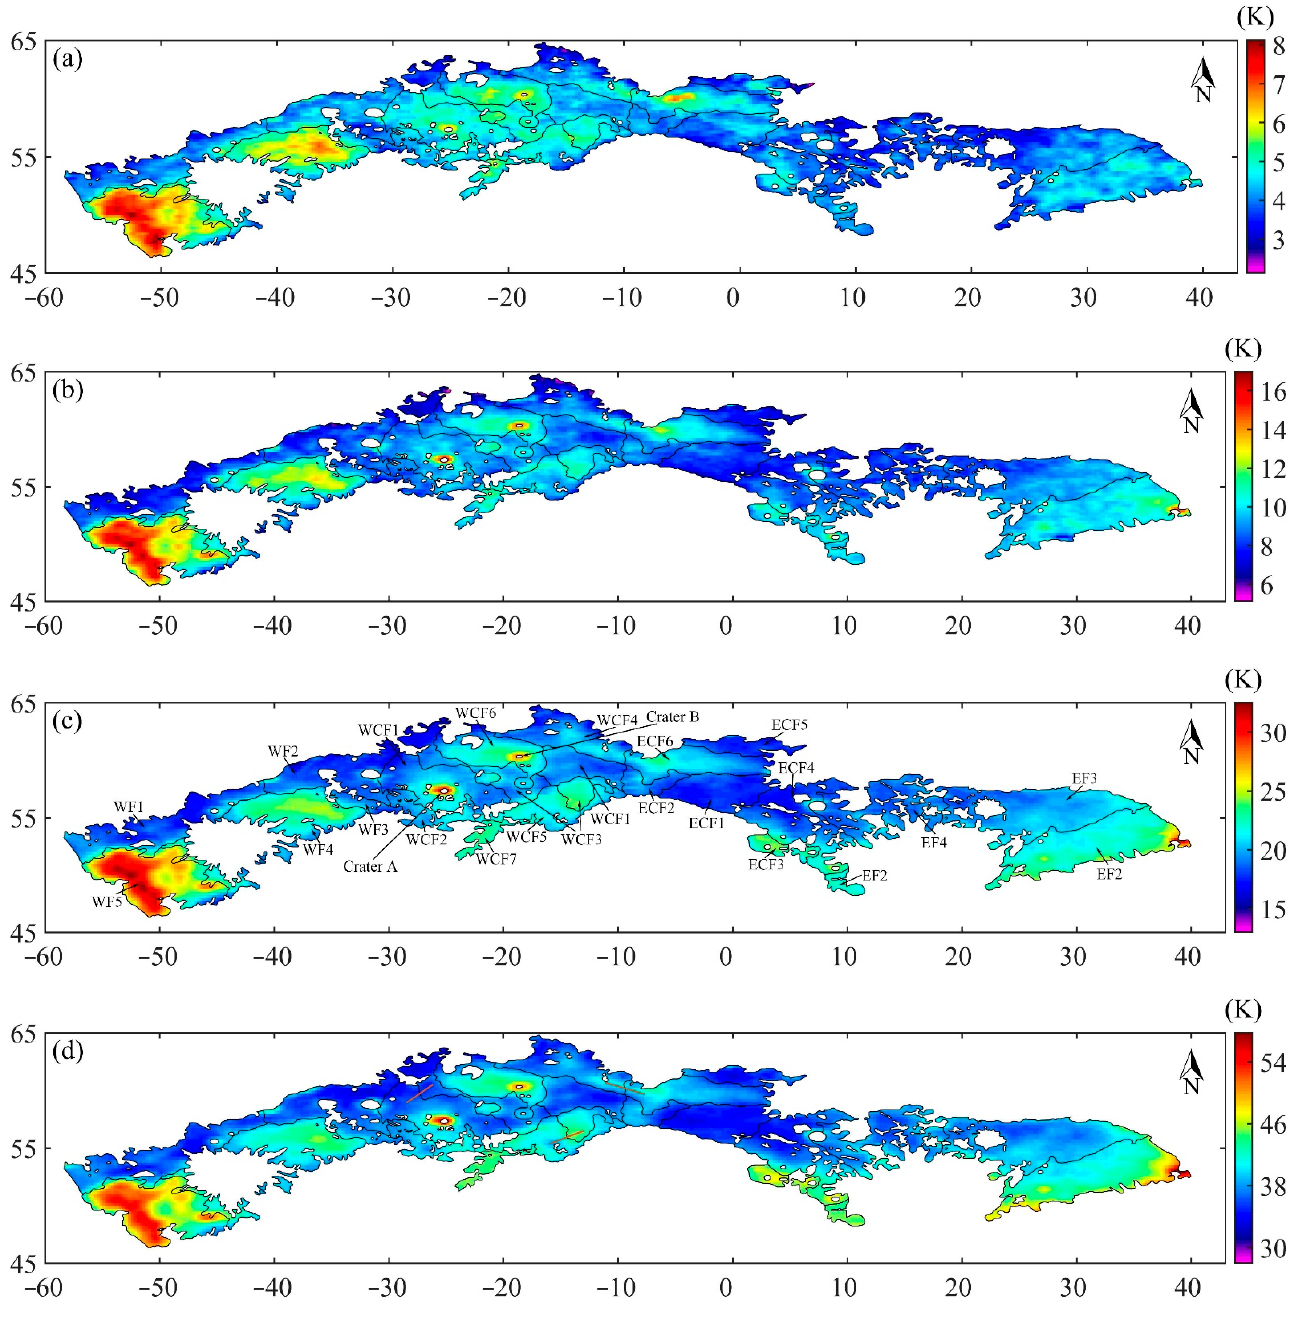
Figure 6. TB difference maps of Mare Frigoris: ( a ) 3.0 GHz, ( b ) 7.8 GHz, ( c ) 19.35 GHz, and ( d ) 37 GHz (equidistant cylindrical projection). The black lines are the geologic boundaries of Mare Frigoris mapped by Kramer et al. [2]. The orange lines are the profiles from the western WCF1 unit to the western WCF3 unit, from the WCF4 unit to the ECF6 unit, and from the WCF5 unit to the eastern the WCF3 unit. Crater A and Crater B are two craters with TB anomalies, as discussed in Sections 3.2.2 and 4.2.1.